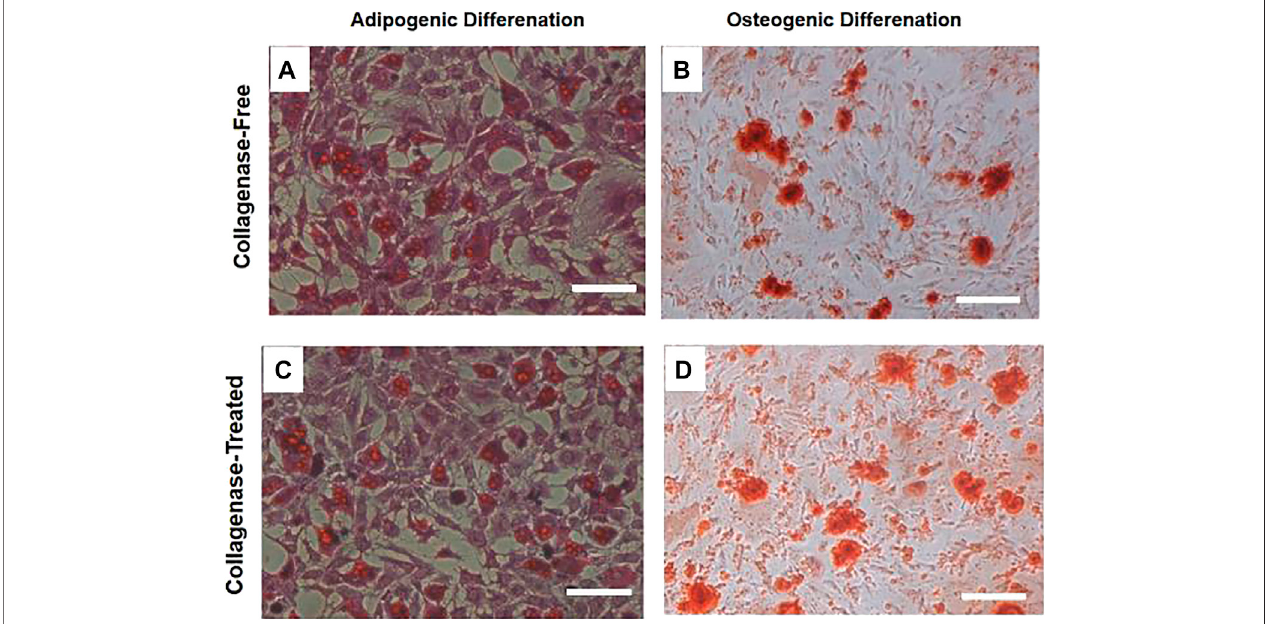
FIGURE 5 | Staining diagram of lipogenic and osteogenic induction and differentiation of two IPFP-SCs obtained by the without enzyme method and digestion method. After adipogenic induction and differentiation of the two cells, they were treated with oil red. On staining, fused lipid droplets (A,C) could be observed, osteogenic-induced alizarin red staining could be observed, fused calcium nodules (B,D) could be observed, and relatively many images of calcium nodules could be seen in the results of enzymatic digestion sources. Scale bar = 200 μ m.